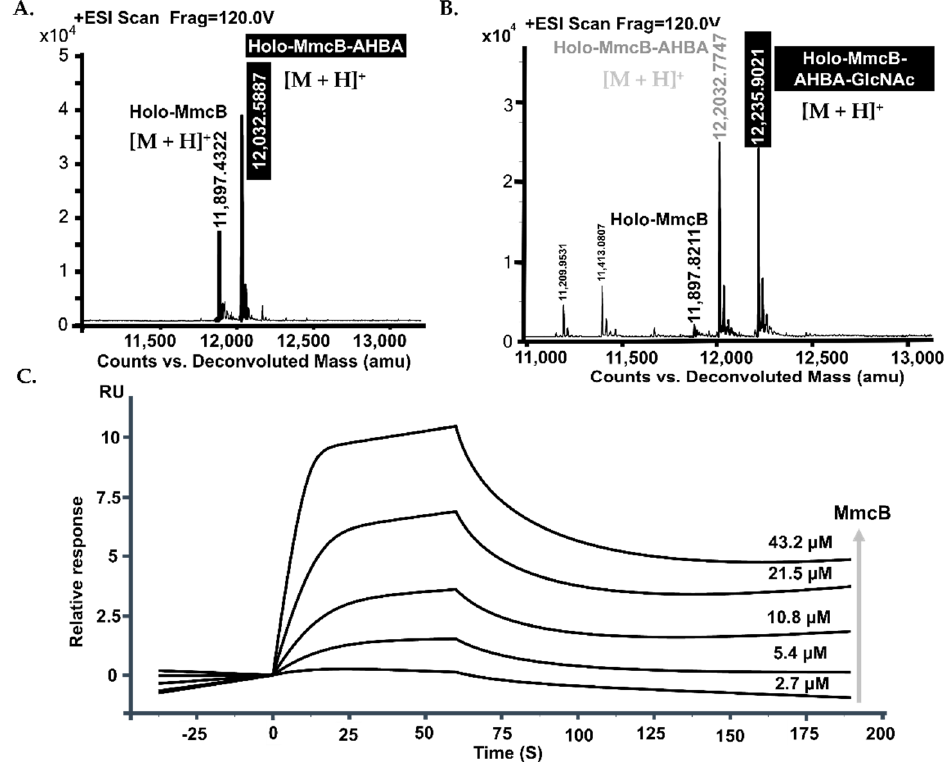
Figure 5. MitB catalyzed the glycosylation of MmcB-tethered AHBA. ( A ) ESI-MS analysis of the formation of MmcB-AHBA. ( B ) ESI-MS analysis of the formation of MmcB-AHBA-GlcNA. ( C ) The determination of the interaction between MitB and MmcB by Biacore biosensor assay.